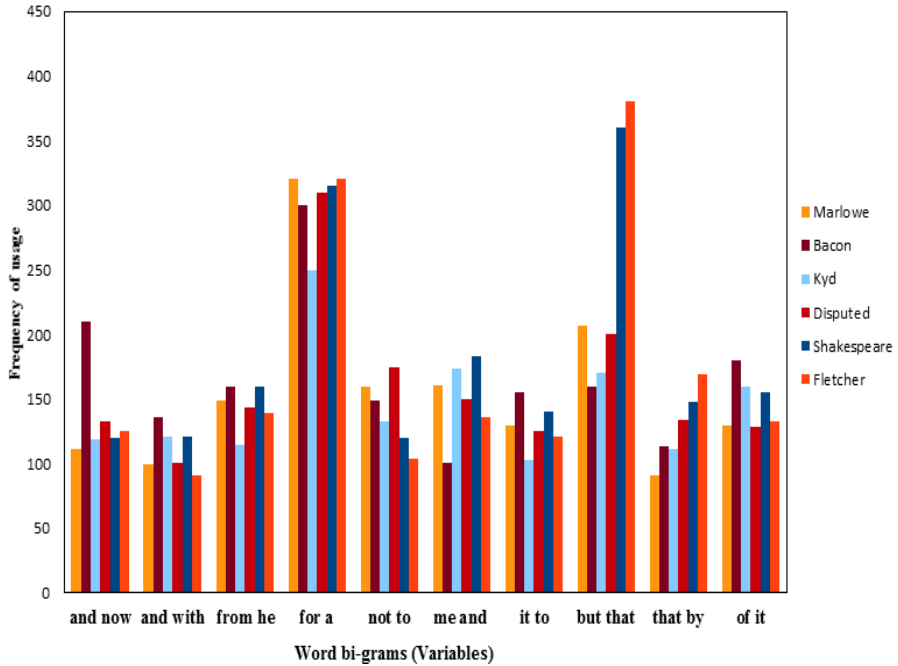
Figure 26. Words bi-gram centroid-based bar plot for all the authors tested.